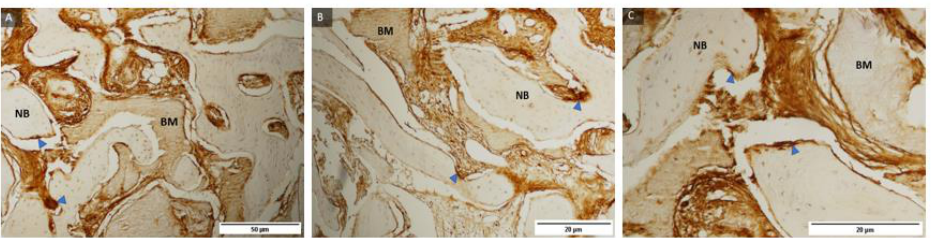
Figure 5. Examples of preparations of control group ( A – C ) and Osx immunohistochemical staining of bone sections after implantation of transcription factor Osx with labeled newly formed bone (NB), residual biomaterial (BM), and cells with 3 (+++) Osx expression (triangle marked in blue). 100, 200 and 400× magnification .